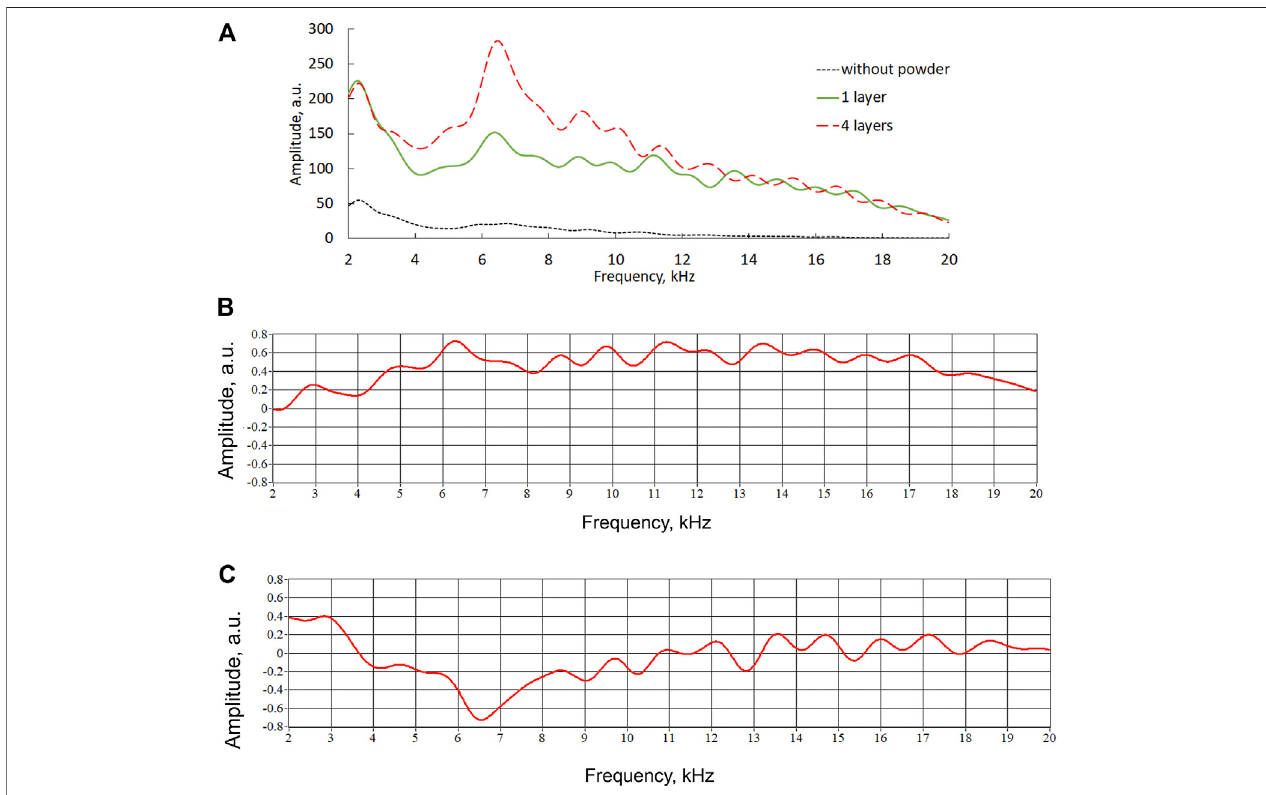
FIGURE 9 | Cumulative amplitude of AE signals for six tracks in different sets: no powder (dotted line), 1 layer (30 µm as reference, solid line) and four layers (120 μ m, dashed line) of powder thickness (A) . Signature curves of “ reference – no powder ” (B) and “ reference – thick powder layer ” (C) .